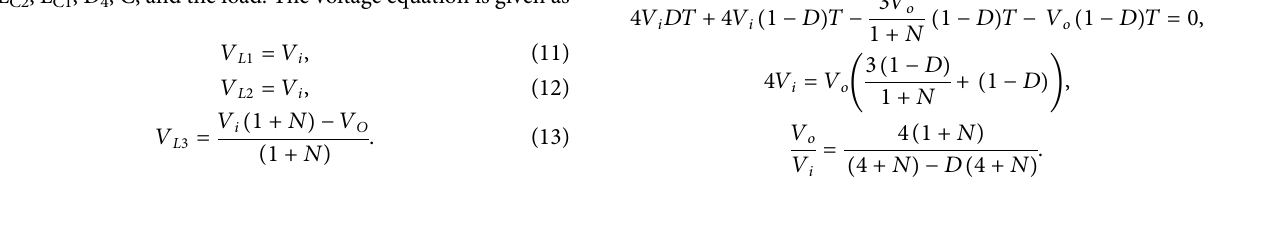
The relationship between the central winding and external winding voltage is given as Mode 4: as shown in Figure 3D , the switches S 1 and S 2 are initially turned on, while S 3 is turned off. Current from the battery Voltage gain (M) is the ratio of output voltage to the input fl ows through the winding L 1 and switch S 1 , and through the voltage is given winding L 2 and switch S 2 . The battery current also conducts L 3 , D 3 , L C2 , L C1 , D 4 , C, and the load. The voltage equation is given as